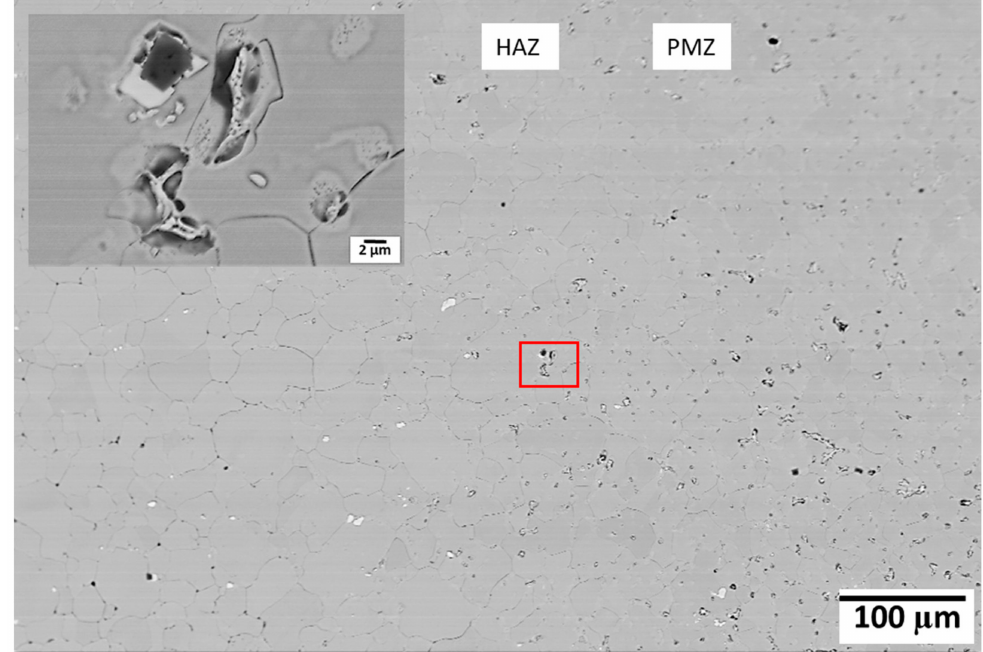
Figure 13. Liquation cracking in HAZ of wrought Alloy 718; inset showing the marked area.